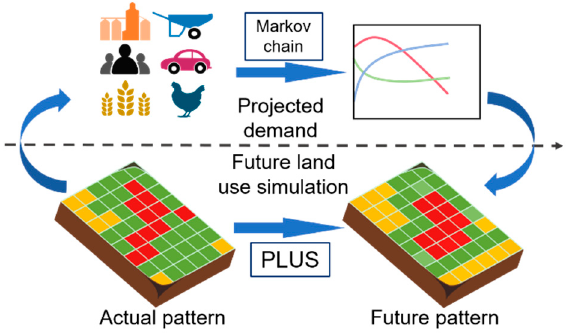
Figure 4. Schematic diagram showing the coupling of the Markov chain and patch-generating land use simulation model.